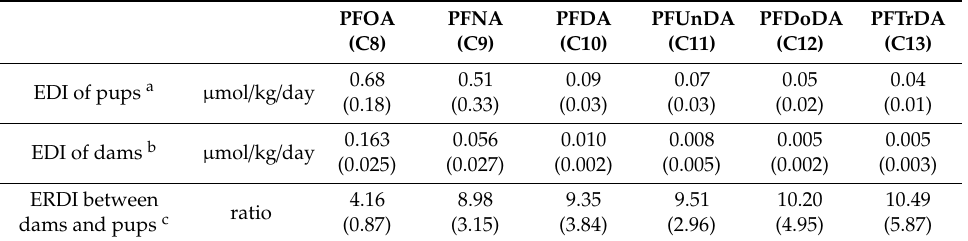
Table 3. Estimated lactational transfer from dams to pups.